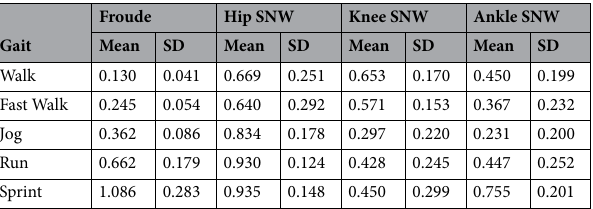
Table 1. SNW values for each joint at each speed. Mean Froude numbers and specific net work (SNW) values with standard deviations (SD) for each joint at each